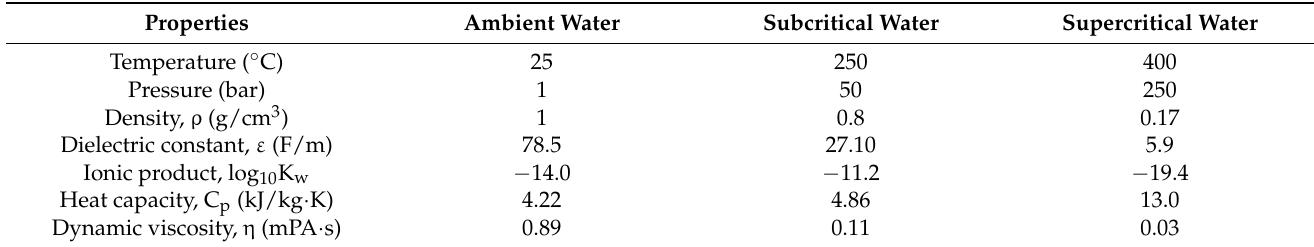
Table 11. Properties of water at different conditions. Adapted with permission from [58]; published by Elsevier,